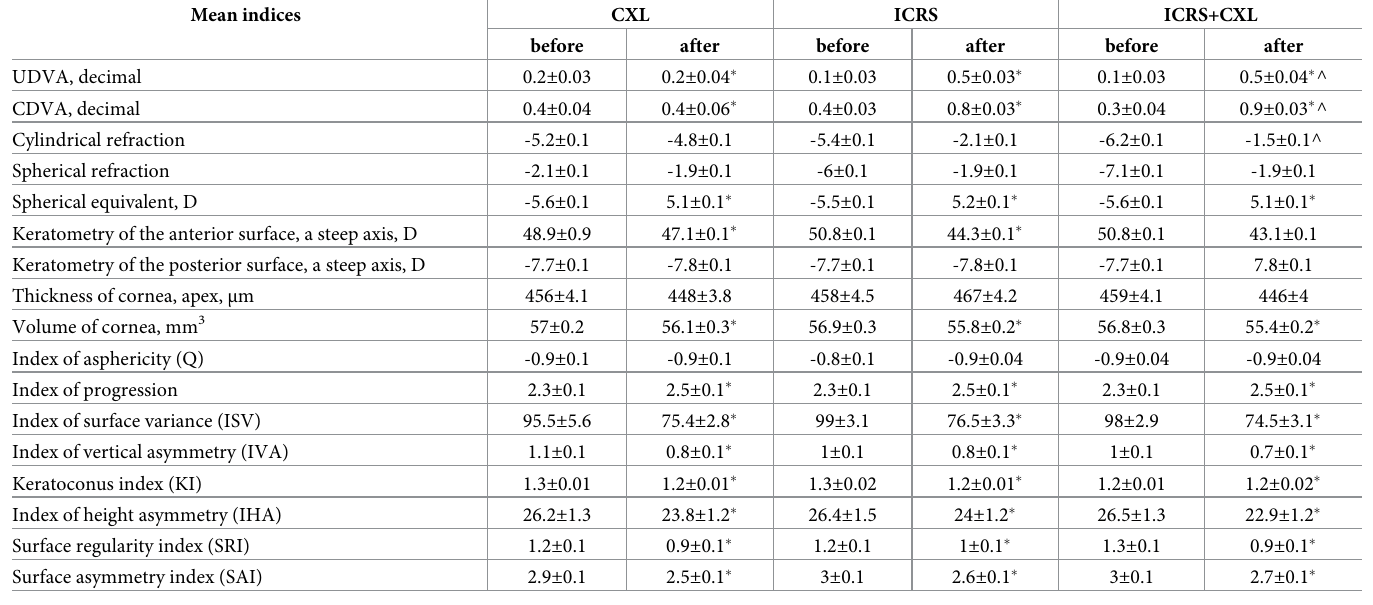
Table 1. Clinical parameters before and 6 months after CXL, ICRS and